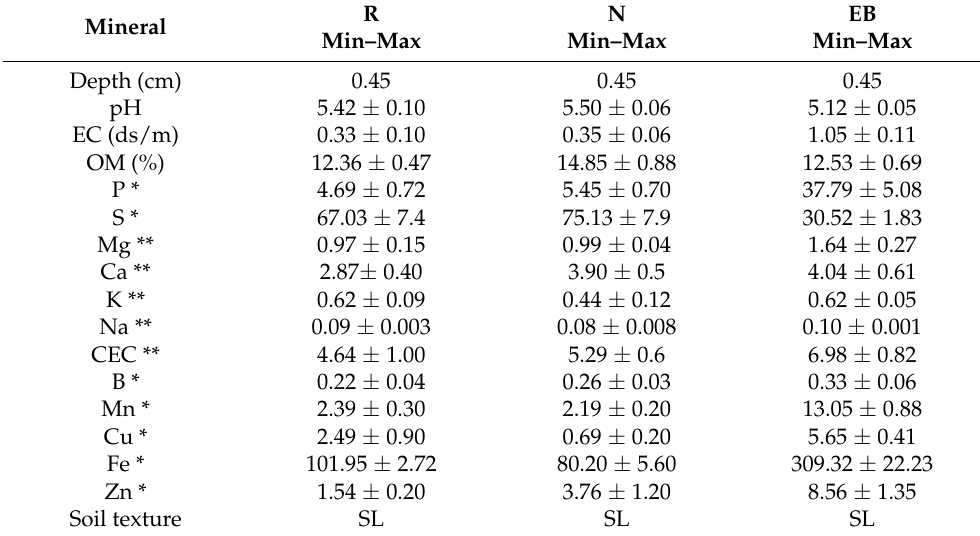
Table 1. Ranges of chemical contents of the soils in the experimental avocado orchards.